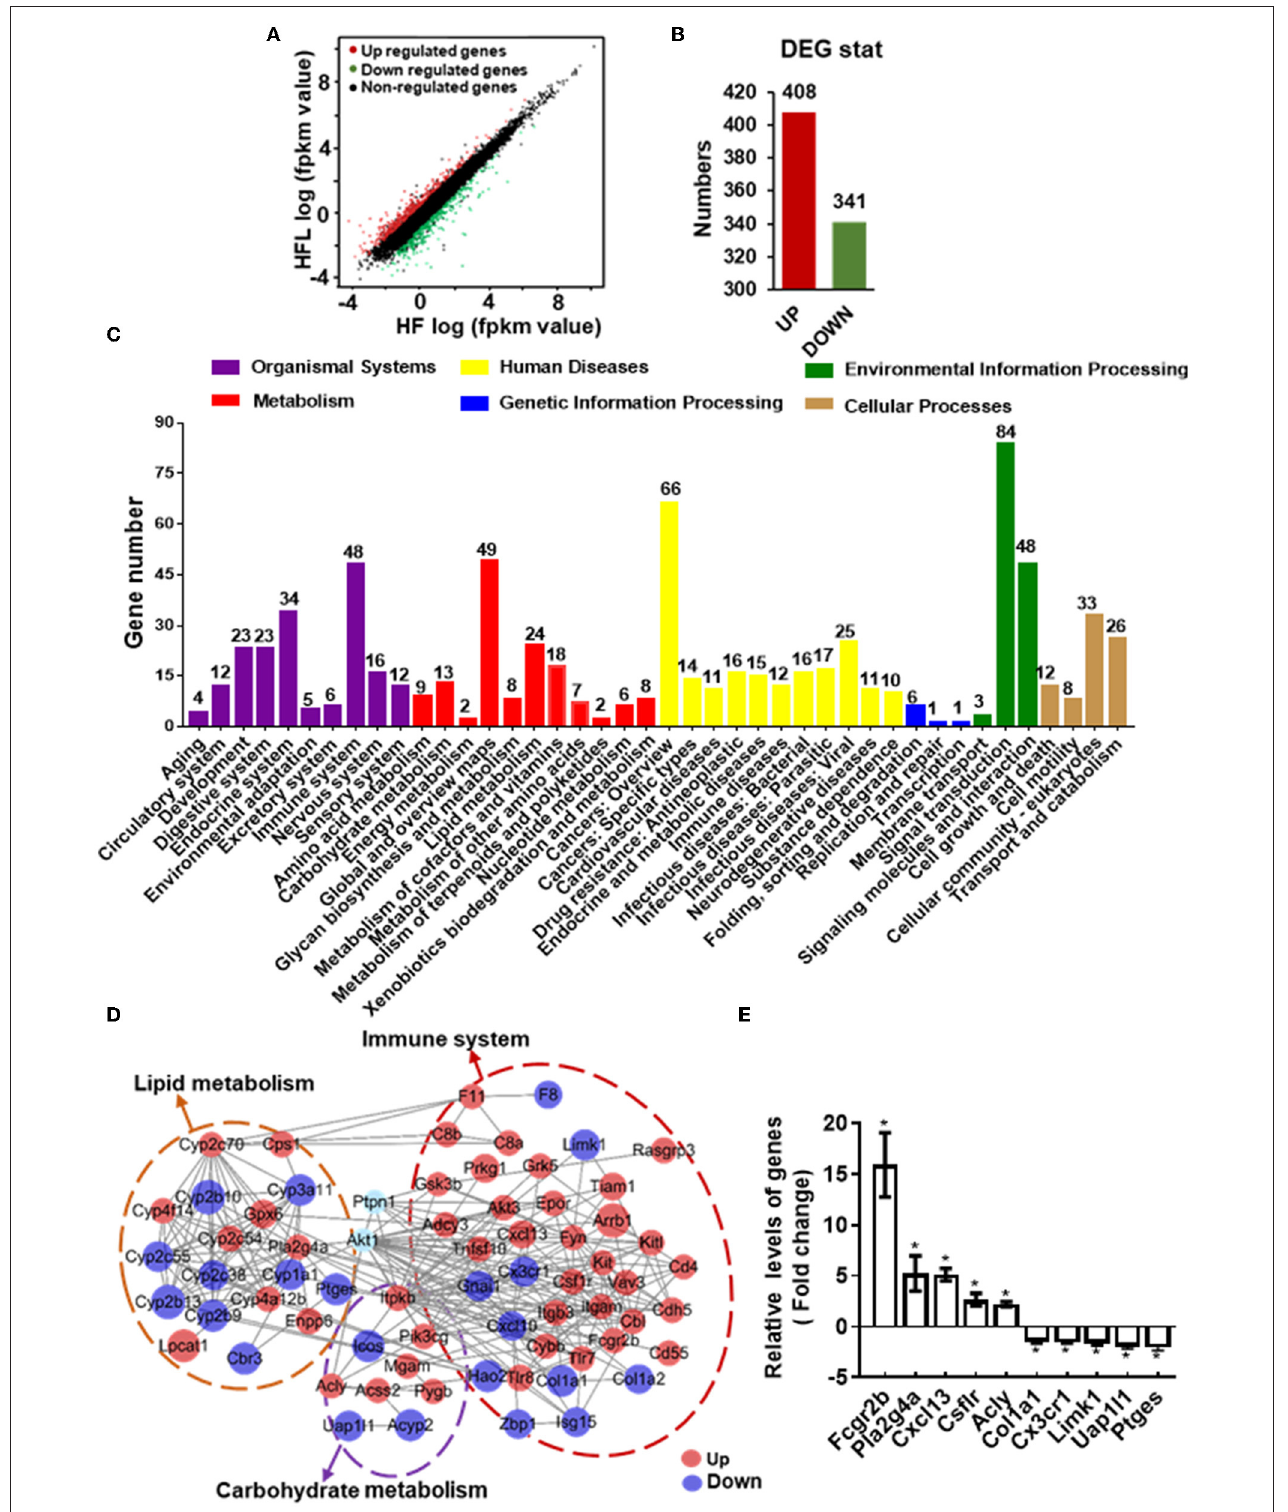
FIGURE 6 | Lentinan modulated hepatic transcriptome for immune and metabolism. (A) Scatter plots of genes in pairwise of the HFL group vs. the HF group. The x-axis and y-axis present gene expression levels. (B) The number of differentially expressed genes (DEGs). (C) KEGG pathway classification of DEGs for the HFL group vs. the HF group. All second-level categories are grouped in top categories in different colors ( n = 3). (D) PPI network by string analysis of DEGs involved in lipid